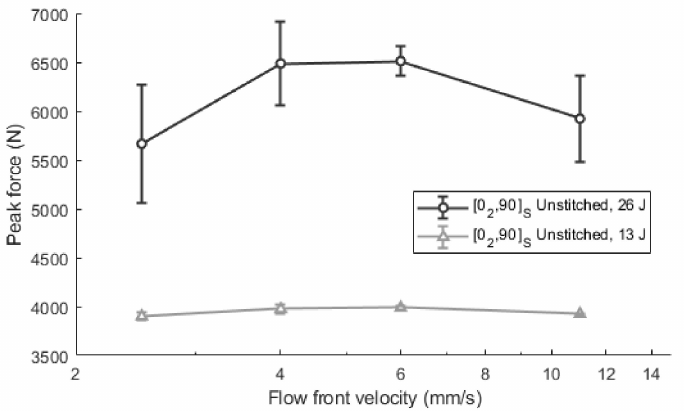
Figure 7. Maximum impact force in unstitched [0 2 , 90] S laminates at 13 J and 26 J.